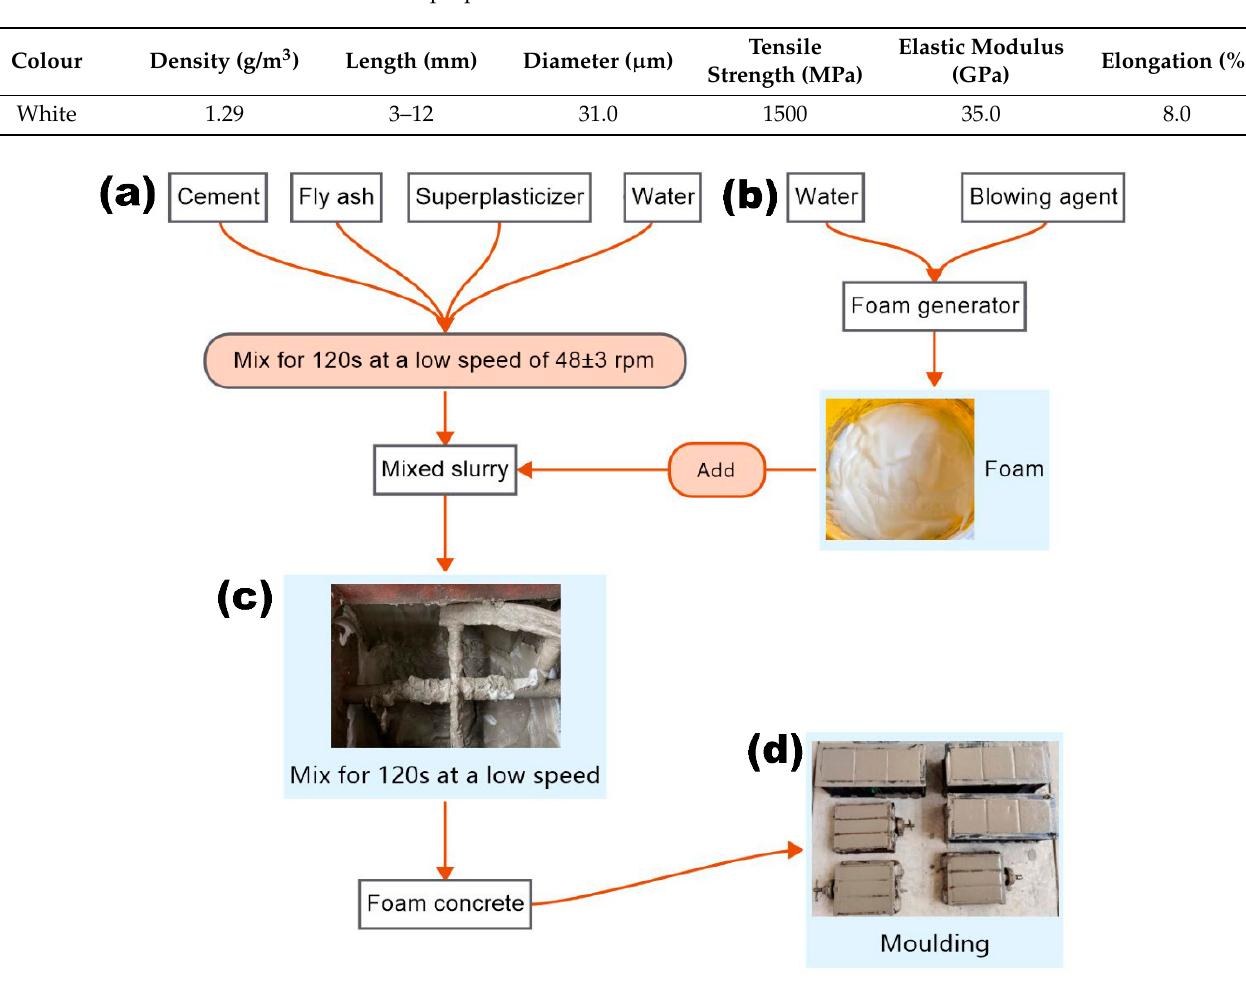
Table 4. Basic properties of PVA fiber.